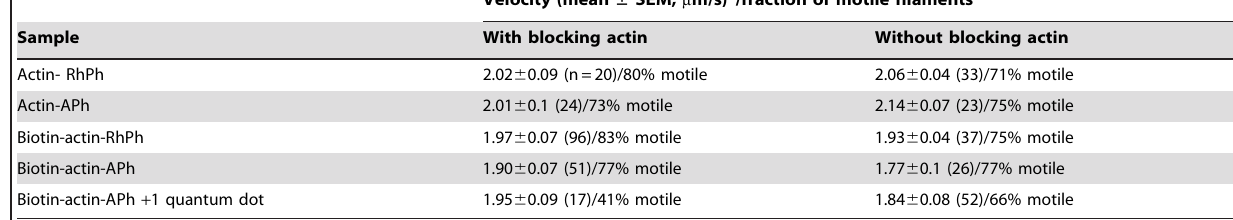
Table 1. Effect of covalent biotinylation and quantum dot attachment on HMM induced actin sliding.